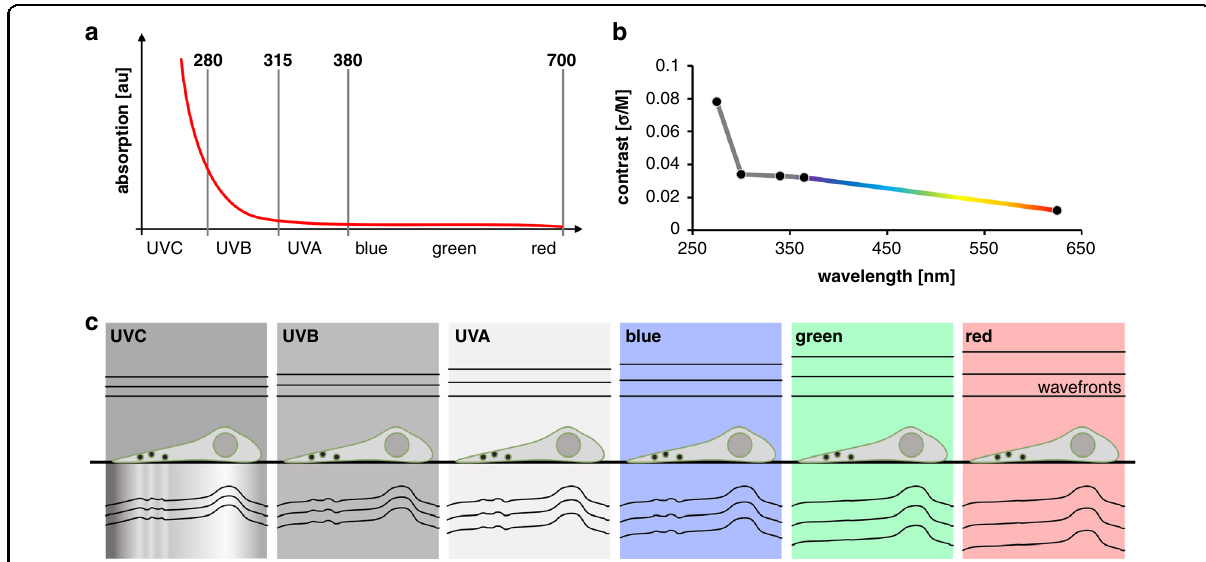
Fig. 1 Absorption and contrast difference at different wavelengths, measured on liver cells. a Conceptual “ hockey stick ” fi gure of tissue absorption as observed in many biological materials 10 – 13 . b Measured contrast (standard deviation over median) at different wavelengths in bright fi eld microscopy of liver cells. c Schematic diagram of light interacting with liver cells containing nano-sized fenestrations present on the cell membrane (shown in dark circles). In the UVC, both the real refractive index and the extinction coef fi cient leave an appreciable imprint on the probing light. A phase retrieval algorithm can disentangle the real and imaginary parts from intensity images in a quantitative manner